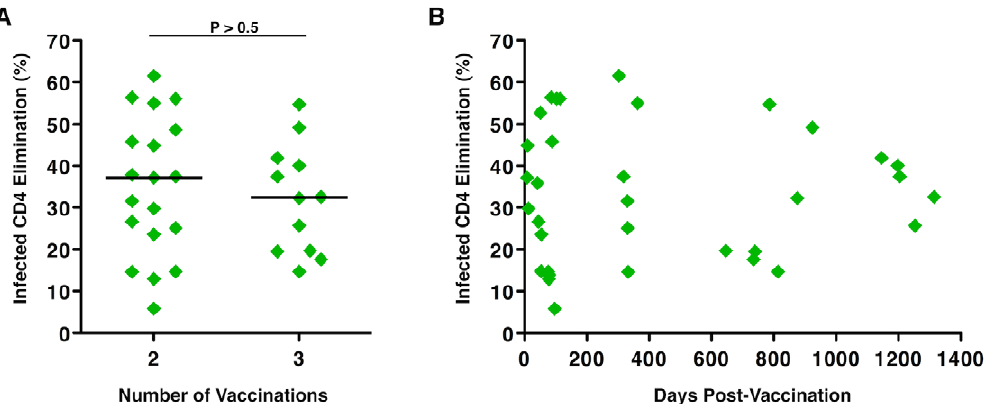
Figure 2. Numbers of immunizations and time from last vaccination did not correlate with the magnitude of Ad5/HIV vaccine- induced HIV-specific CD8 + T-cell cytotoxic responses. (A) ICE responses were compared by the Wilcoxon two-sample test between individuals who had received 2 (n=19) versus 3 (n=12) immunizations with the Ad5/HIV vaccine through protocols 071 or 502, respectively. Horizontal lines represent median values. (B) ICE responses did not correlate with the number of days following the last vaccination (p . 0.5). Correlation was determined by the Spearman rank method.